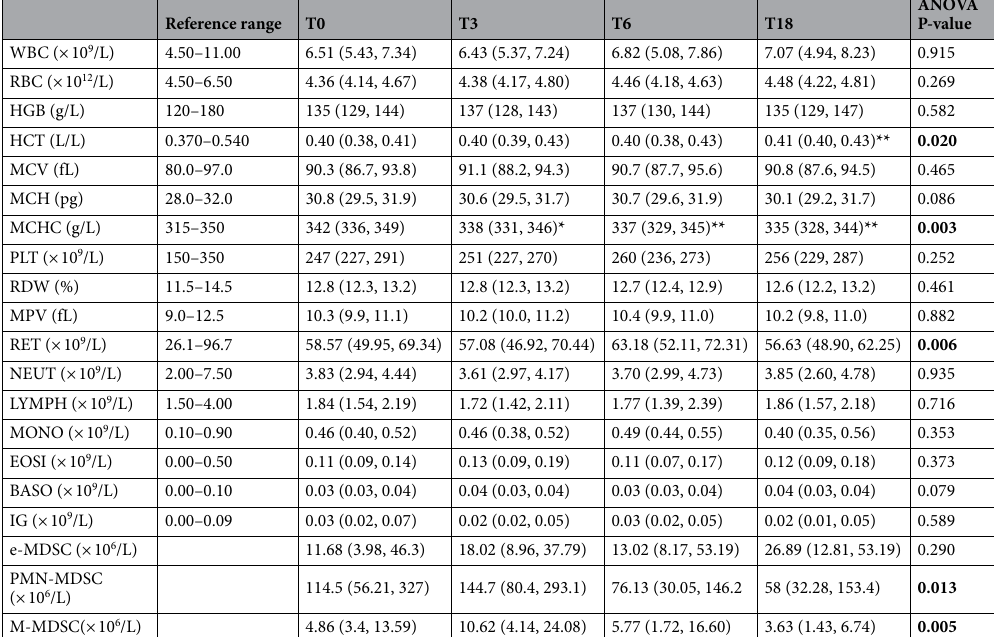
Table 1. Whole blood hematologic counts a before, during, and after ranitidine treatment. WBC white blood cell count, RBC red blood cell count, HGB hemoglobin, HCT hematocrit, MCV mean corpuscular volume, MCH mean corpuscular hemoglobin, MCHC mean corpuscular hemoglobin concentration, PLT platelet count, RDW RBC distribution width, MPV mean platelet volume, RET reticulocyte count, NEUT neutrophil count, LYMPH lymphocyte count, MONO monocyte count, EOSI eosinophil count, BASO basophil count, IG immature granulocyte count. Statistical analysis was performed using a Friedman’s test (indicated p-values), or where data distribution was appropriate using repeated measures, one-way ANOVA followed by Dunnett’s multiple comparison, using T0 as control. * P < 0.05, ** P < 0.01 compared to T0. a CBC with WBC differential counts were assessed before ranitidine treatment (T0), after 3- and 6-weeks of treatment (T3 and T6), and after 12 weeks treatment cessation (T18). Data are presented as median (interquartile